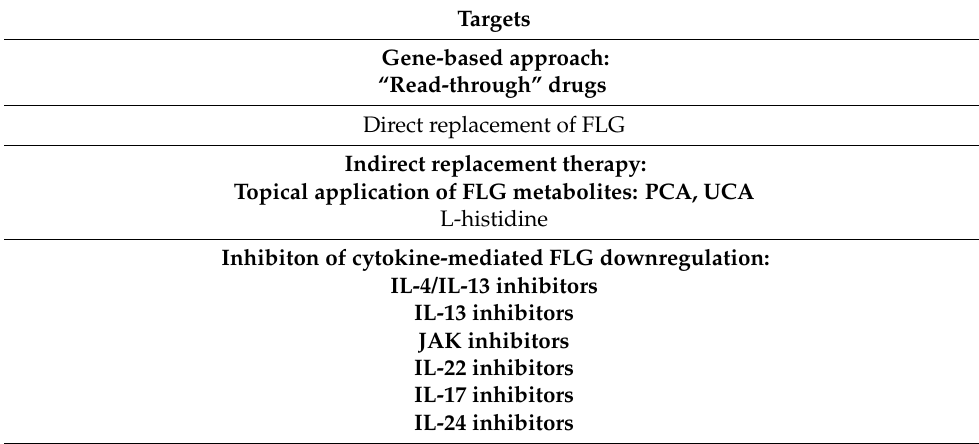
Table 1. Potential therapies targeting FLG